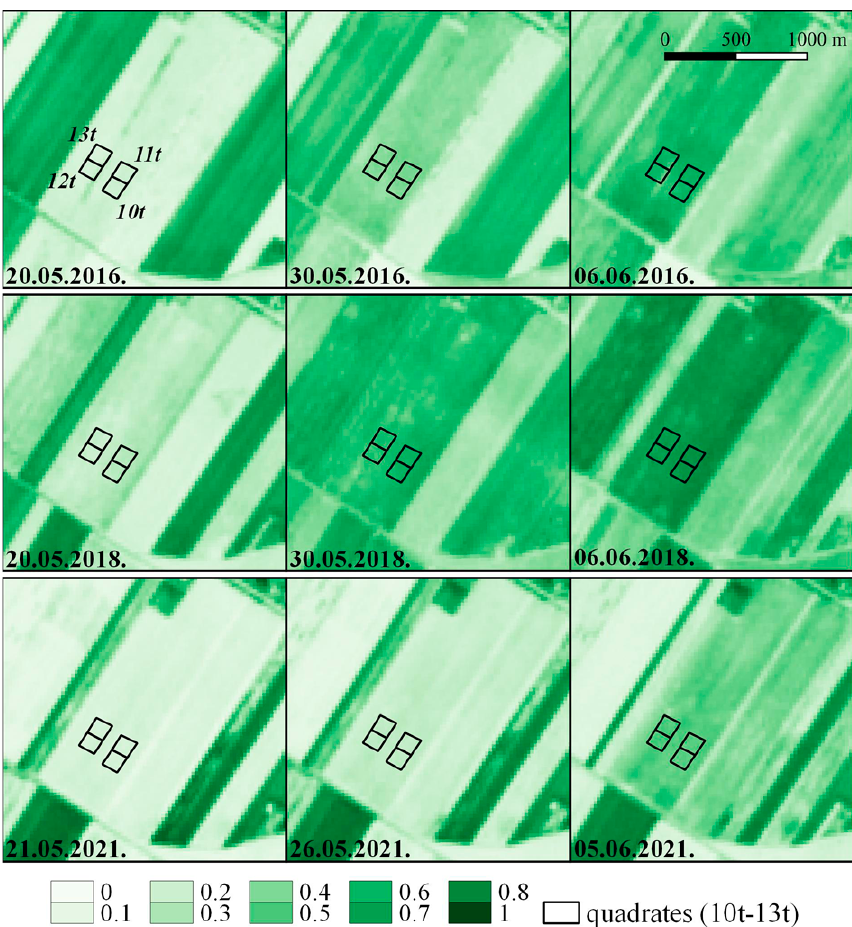
Figure 8. Short-term impact of sewage sludge disposal in 2017 on sunflower yield based on Sentinel-2 EVI